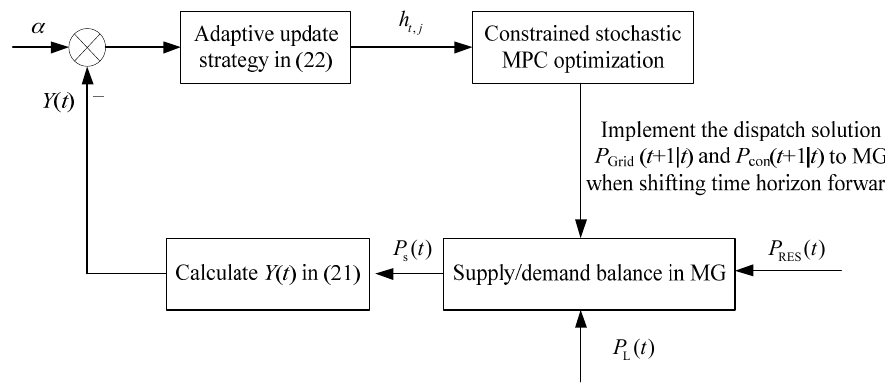
Figure 1. Closed-loop of constraint violation in adaptively constrained stochastic model predictive control (MPC).